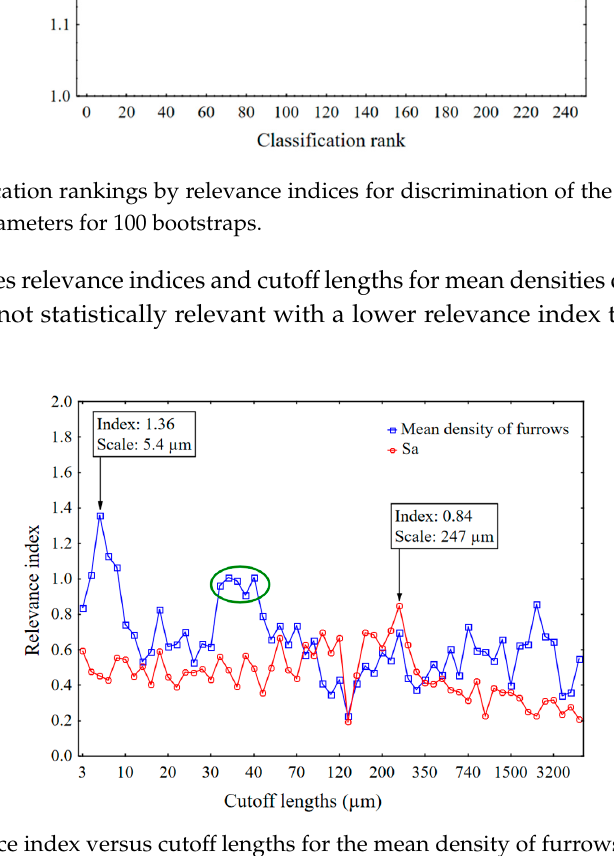
Figure 11. Relevance index versus cutoff lengths for the mean density of furrows and Sa . Ceramics, Mehlum curvatures and a band pass filtering. Classification rankings by relevance indices for discrimination of the 7 materials by 75 topographic parameters for 100